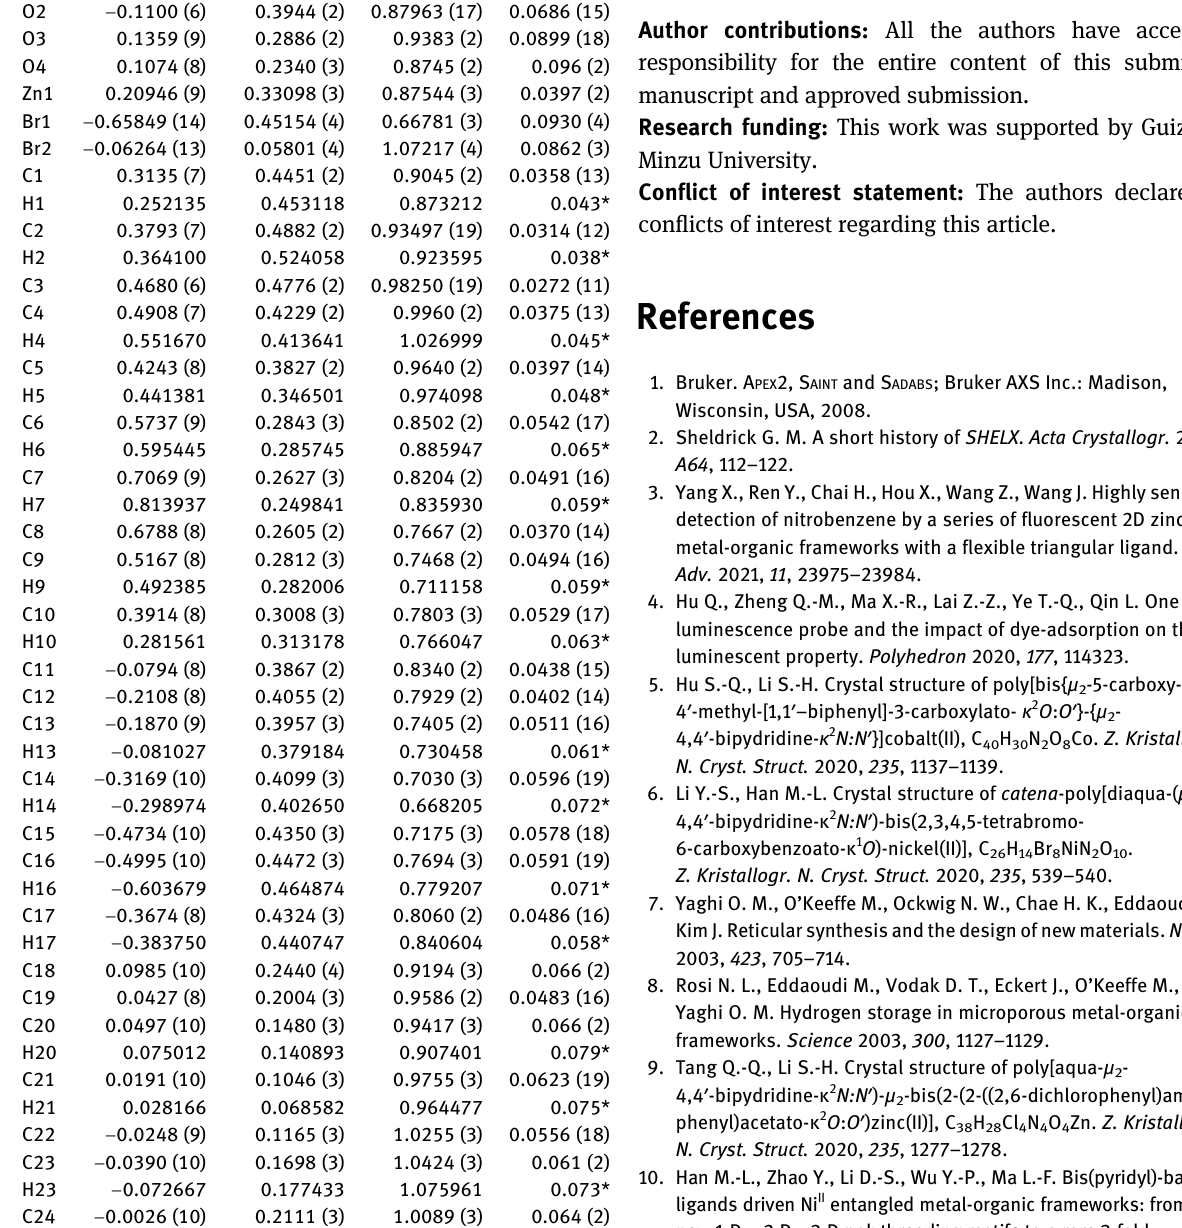
Table  : Fractional atomic coordinates and isotropic or equivalent isotropic displacement parameters (Å 